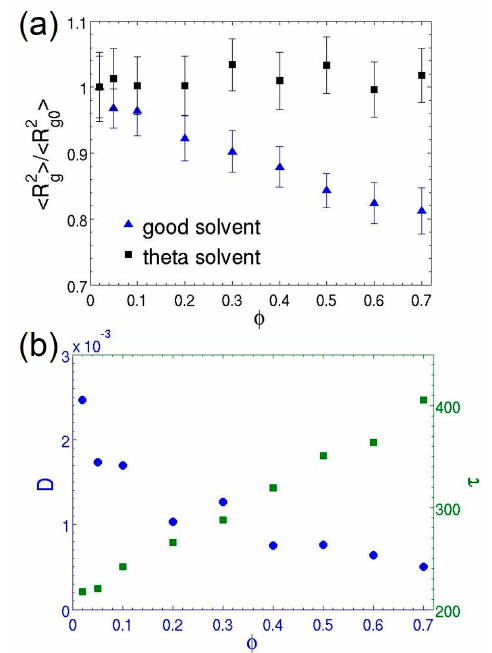
Figure 7. ( a ) Dependence of the normalized mean-square radius gyration (with respect to the values in the dilute limit 2 0 g R ) of the N = 30 polymer chains on their volume fraction for good ( A ps = − 40) and theta ( A ps = − 38.5) solvent conditions; ( b ) The diffusion coefficient and relaxation time of the chains in the theta solvent as functions of the volume fraction. The error bars represent the standard deviations of the ensemble averages, and their sizes are smaller than the symbols in ( b ).